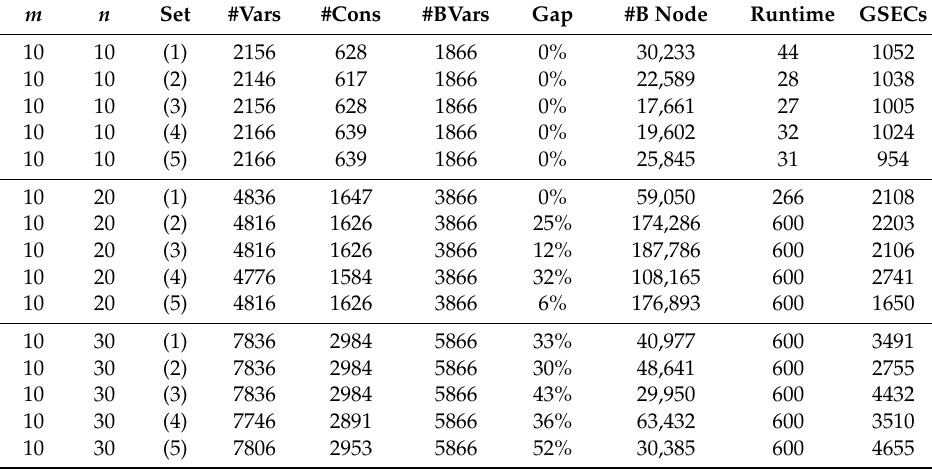
Table 5. Test results of M1 for instance group